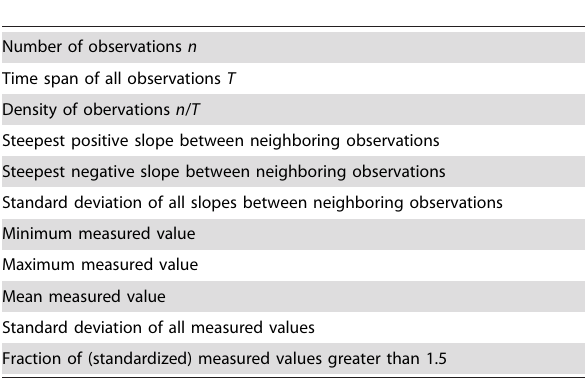
Table 2. Expert Engineered Features.